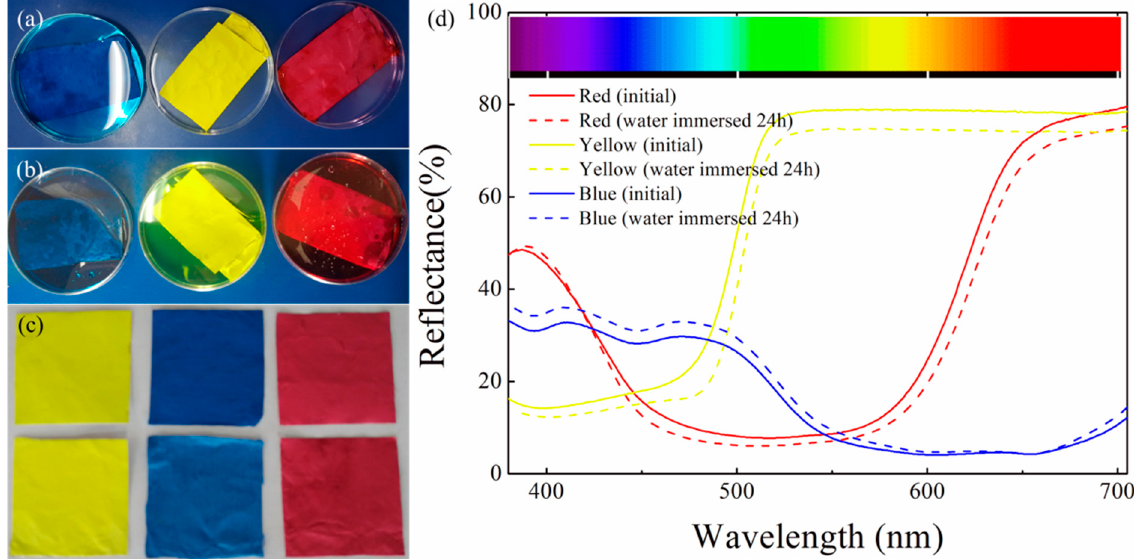
Figure 8. As-spun colored nanofibrous membranes ( a ) immersed in water; ( b ) after 24 h; ( c ) comparing membranes before and after immersion in water; and ( d ) UV-Vis diffuse reflectance spectroscopy of these membranes. From [173], copyright (2016), originally published under a CC-BY license.